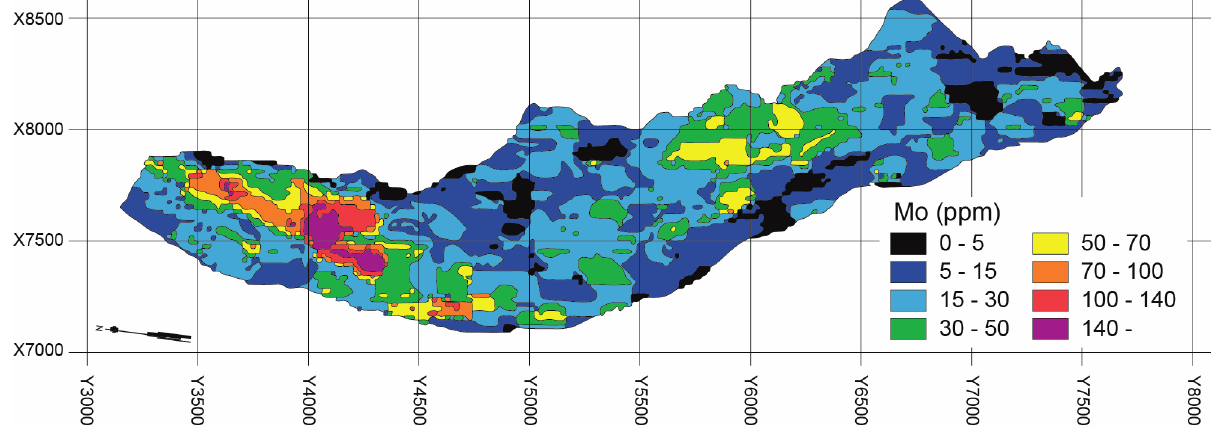
Figure 9. Contoured grade map of Mo at the 300 m level in the Aitik deposit. Grades are taken from the block model of the Aitik mine, and based on ca . 15,000 Mo analysis of drill core